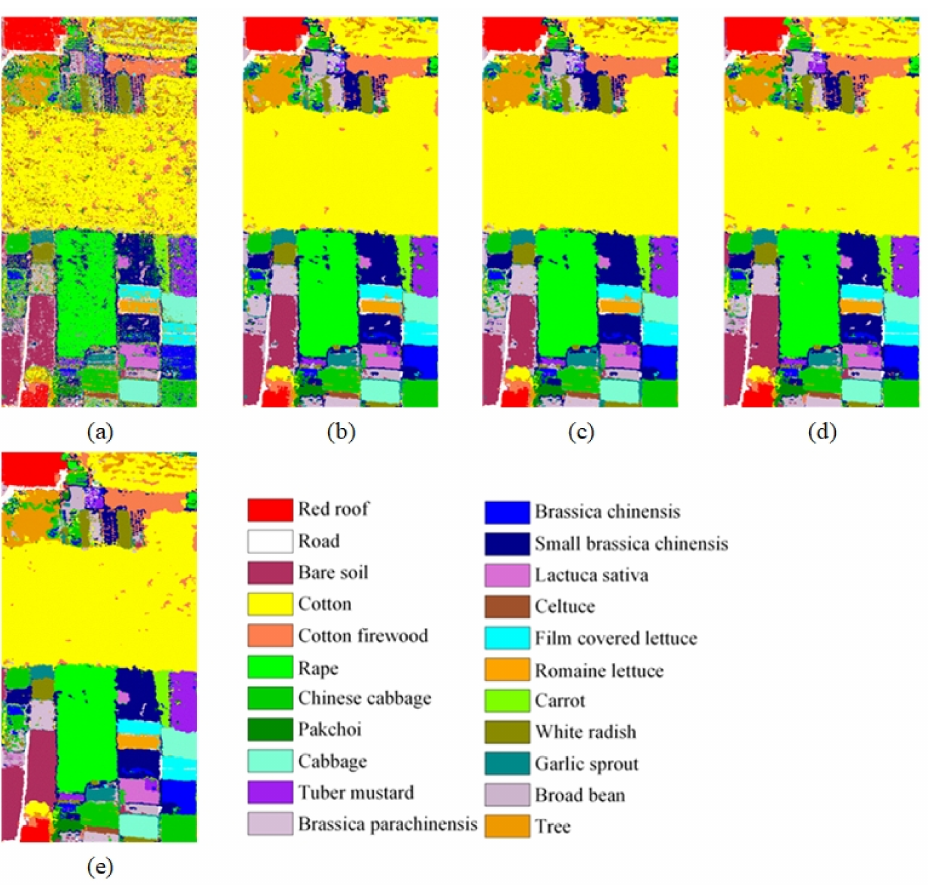
Figure 13. The classification results for the Honghu dataset using SVM: ( a ) Pixel-wise spectral classification; ( b ) MLF; ( c ) MPF; ( d ) MLV; ( e )